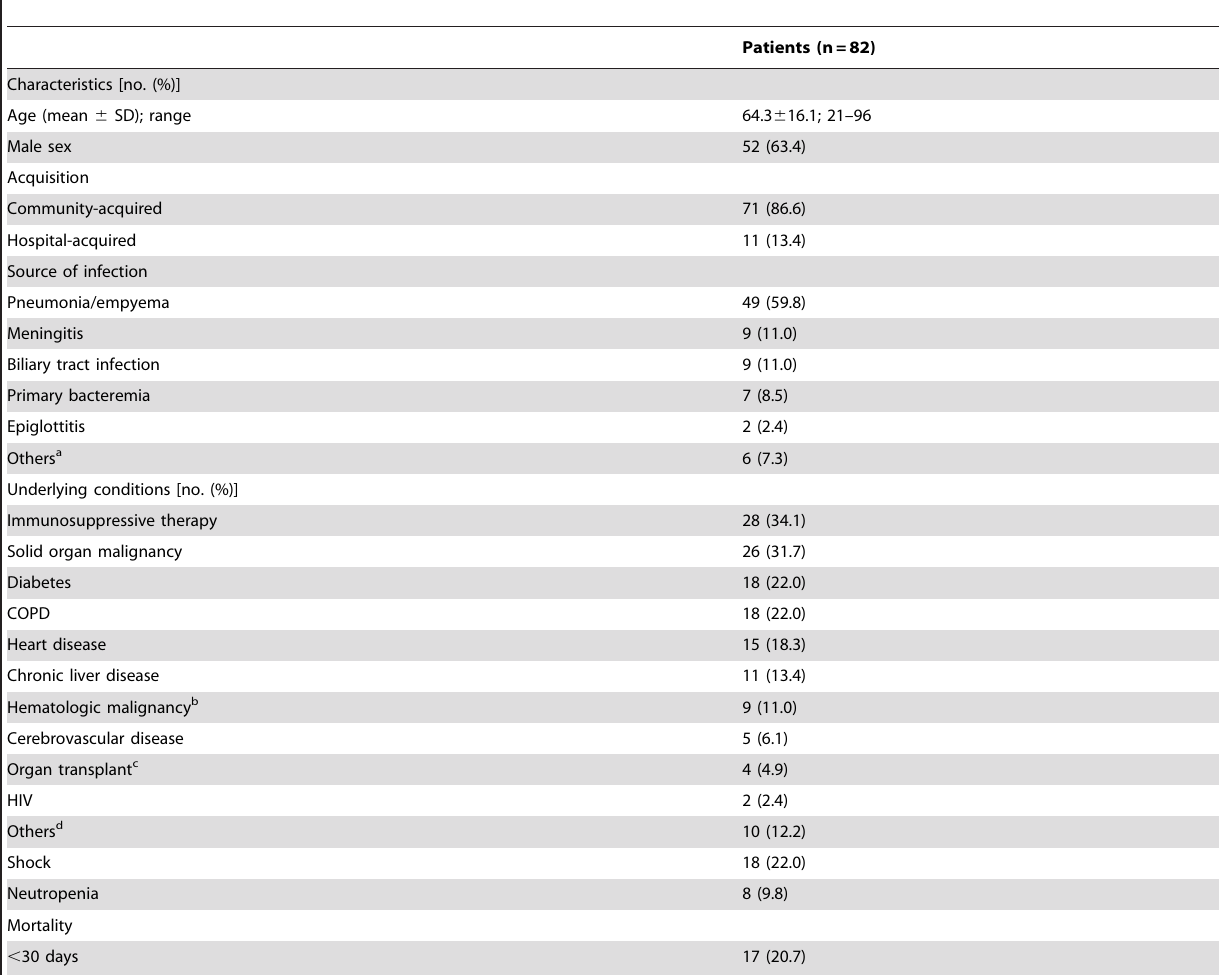
Table 1. Demographic data, clinical characteristics, and underlying conditions of 82 patients with an invasive H. influenzae episode during the period